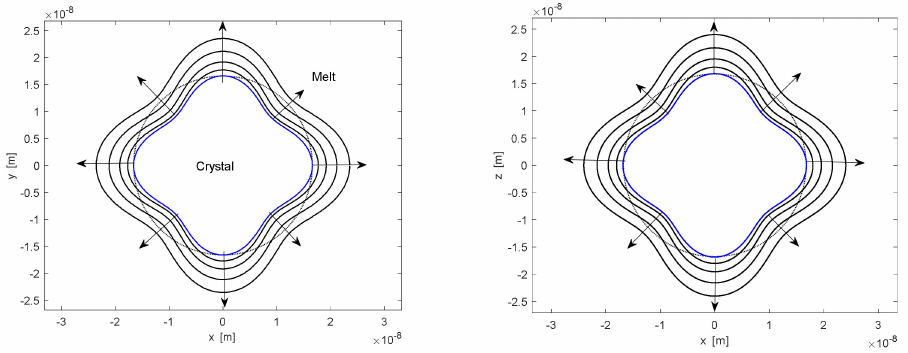
Figure 2. The cross-sectional curves of the interface morphology of the particle under the influence of anisotropic interface kinetics at different times t = 4.5, 6.0, 7.0, 8.0, 9.0 (from inside to outside), where β = 0.25, r 0 = 1.1 R ∗ , Γ = 0.4545, ∆ T = 10. By contrast, the dashed line denotes the interface without the anisotropic effect of interface